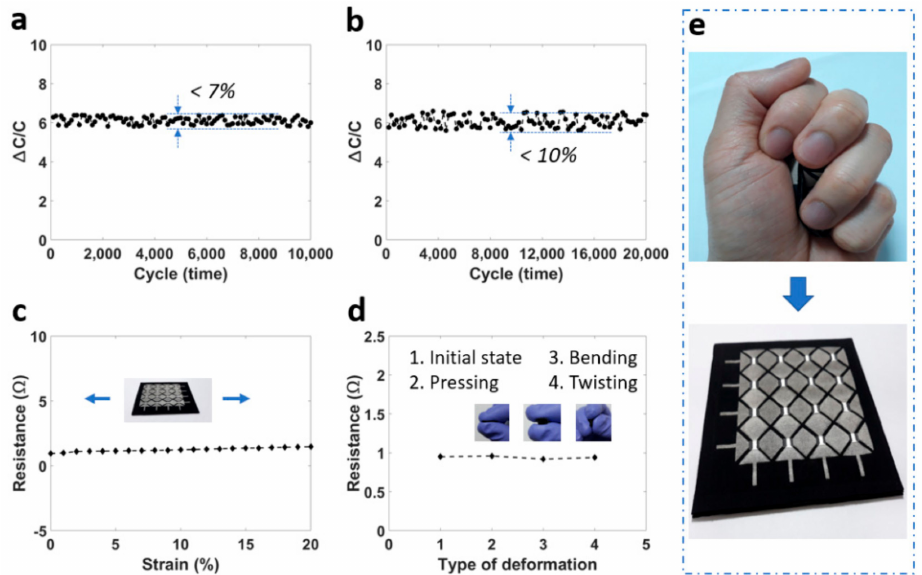
Figure 6. Characteristics of capacitive pressure sensor consisting of ( a ) dynamic durability of the sensor after 10,000 loading / unloading cycles at pressure of 100 kPa, ( b ) dynamic durability of the sensor after 20,000 loading / unloading cycles at pressure of 1000 kPa, ( c ) resistance change of the sensor when stretching from 0 to 20%, ( d ) resistance change of the sensor under di ff erent deformations, and ( e ) state of the e-fabric-skin after large deformation.